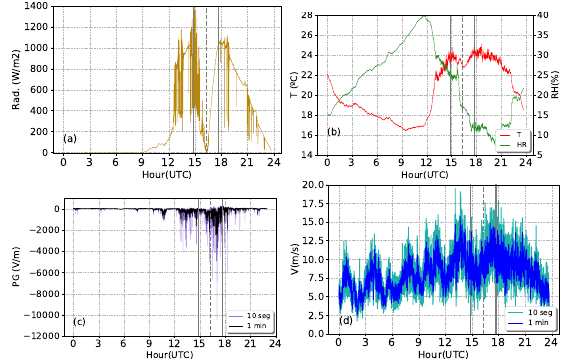
Figure 3: Measurements at Valcheta during the total solar eclipse of 14 December 2020: (a) solar irradiance every 10 seconds, (b) temperature (red) and relative humidity (green) every 10 seconds, (c) PG every 10 seconds (light violet) and the 1 minute average (black), and (d) wind speed every 10 seconds and the 1 minute average (blue and light blue respectively). The vertical grey lines indicate the start, maximum (dashed) and end times of the eclipse for the